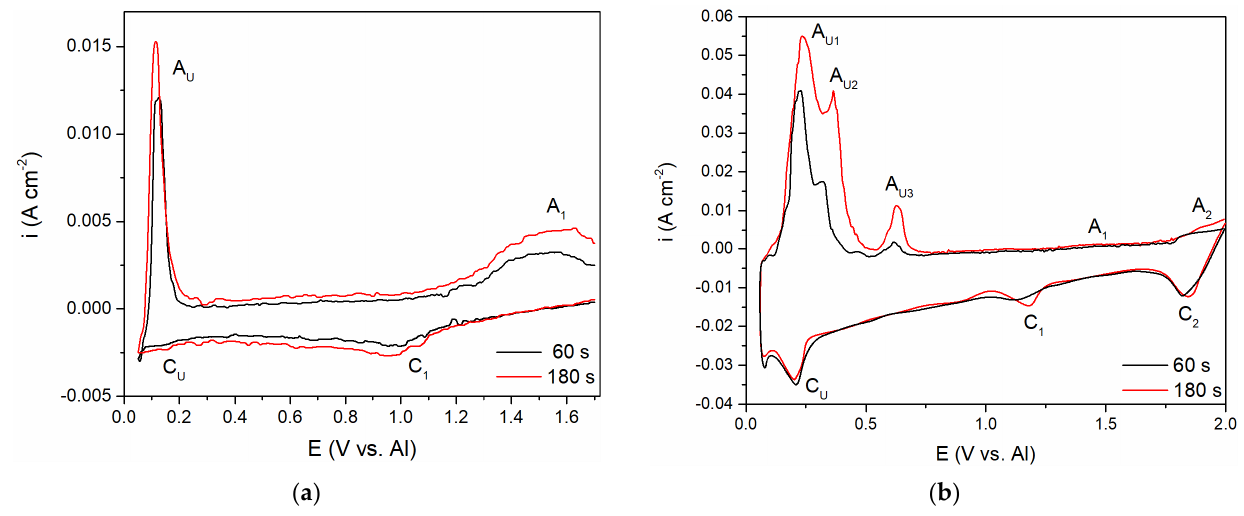
Figure 6. Hold on GC working electrode at potential E C = 0.050 V vs. Al; T = 200 °C, v = 100 mVs −1 ; in: ( a ) the equimolar melt containing anodically dissolved vanadium; ( b ) the equimolar melt with vanadium added by VCl 3 .